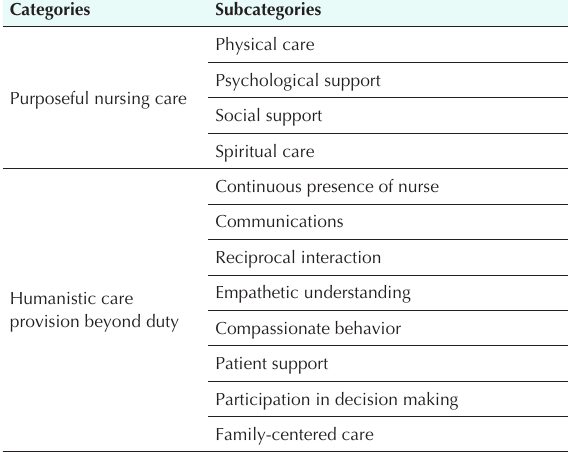
Table 2. Categories and subcategories of the